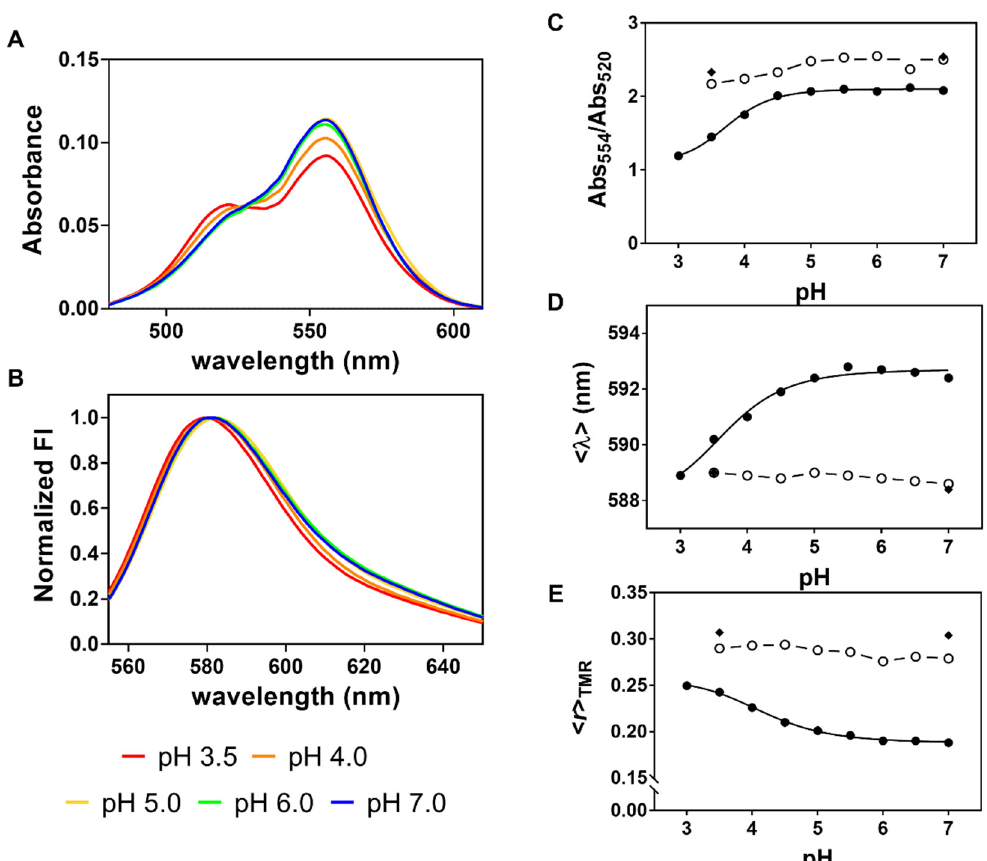
Figure 4. Influence of pH on the spectroscopic properties of the TMR reporter conjugated to the G116C W67 KcsA protein at variable D:P ratios. The samples were prepared with a D:P = 0.05 ( ◆ ), 0.12 ( ○ ), or 0.45 ( ● ). ( A ) Absorbance and ( B ) normalized emission spectra ( λ ex = 490 nm) of the TMR conjugated protein (D:P = 0.45) at pH 3.5, 4.0, 5.0, 6.0, and 7.0. The absorption spectra are characterized by the progressive appearance of a shoulder at ~520 nm corresponding to H-type dimer formation at acidic pHs. The emission spectra present a small red-shift at neutral pHs which is putatively assigned to residual oblique J-type dimer formation. ( C ) The extent of H-dimer and ( D ) putative oblique J-dimer formation for the labeled proteins were monitored by the change in the Abs 554 /Abs 520 ratio and the spectral center-of-mass, ∆ < λ >, with pH, respectively. ( E ) Variation of the steady-state fluorescence anisotropy of the TMR reporter present in TMR-labeled G116C W67 KcsA, <r> TMR , with pH at different degrees of labeling. The measuring conditions were λ ex = 490 nm; λ em = 580 nm. Error bars are smaller than the symbols in most cases. The solid lines (D:P 0.45) correspond to the empirical fits of a Hill equation to the sigmoidal behavior of each data set with pH, giving a ( C ) p K a (K + ) = 3.8 ± 0.1, ( D ) p K a (K + ) = 3.7 ± 0.2, and ( E ) p K a (K + ) = 4.2 ± 0.1, respectively. The dashed lines are just a guide to the eye. The samples contained 5 mM DDM and 200 mM KCl (T = 25 °C).